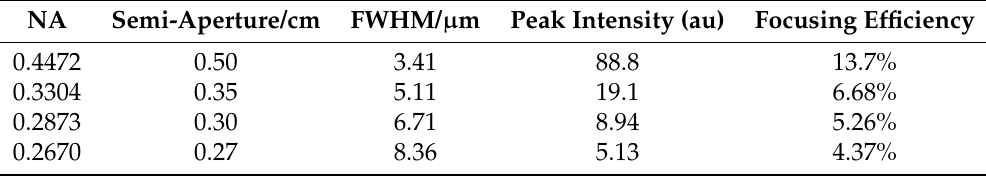
Table 2. Simulated data for the 3000 nm devices with focal length 1